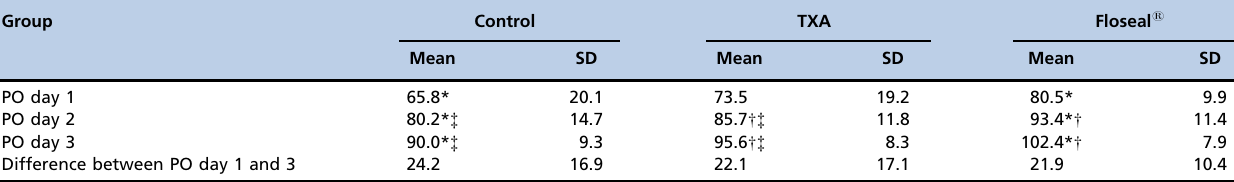
Table 4 - Mean ROM of the knees assessed for the prospective randomized trial comparing Floseal s and TXA for bleeding control after TKA.